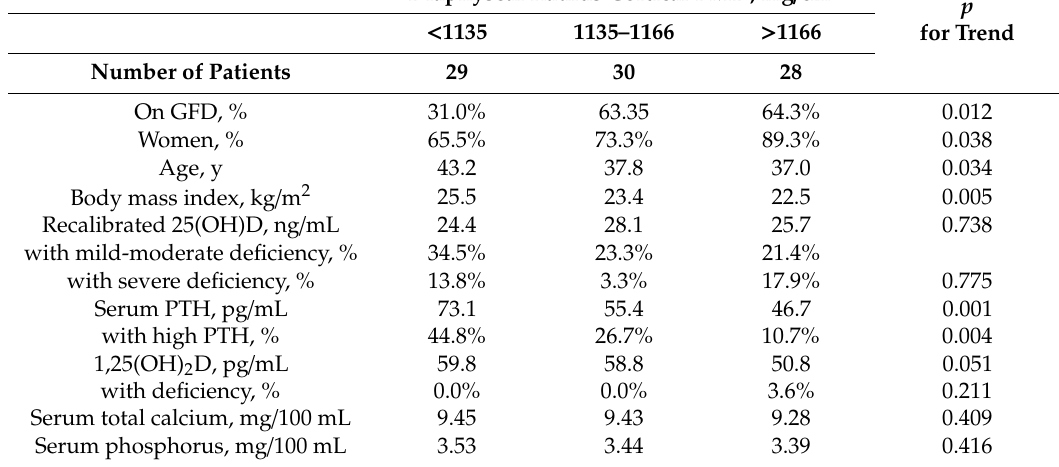
Table 6. Analysis by tertile of diaphyseal radius cortical BMD: Prevalence or mean of gluten-free diet (GFD), sex, age, body mass index, and serum concentrations of 25(OH)D, PTH, 1,25(OH) 2 D, calcium, and